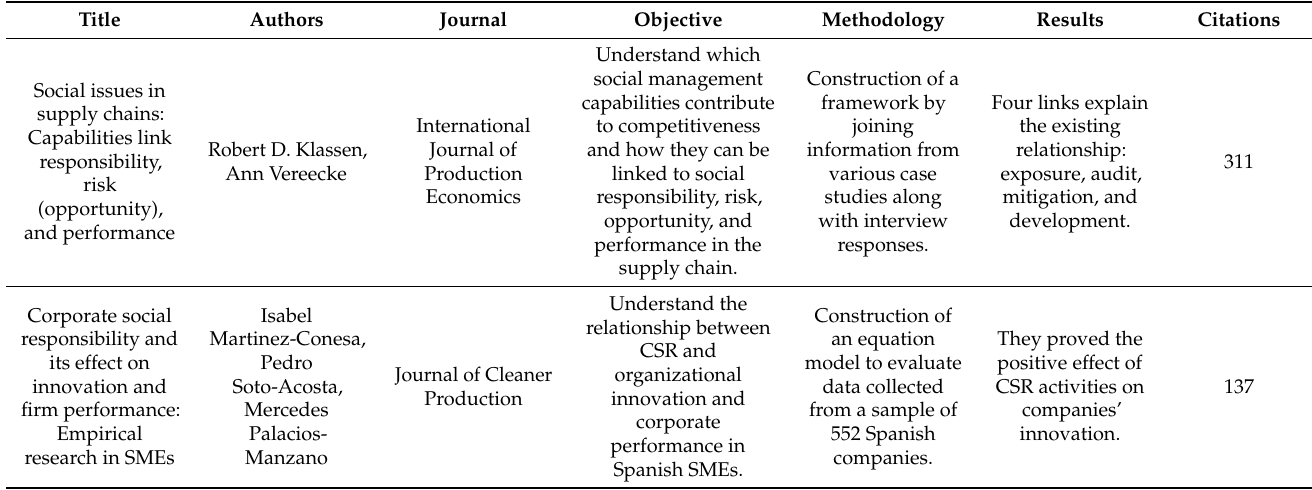
Table 1. Most cited articles within the research